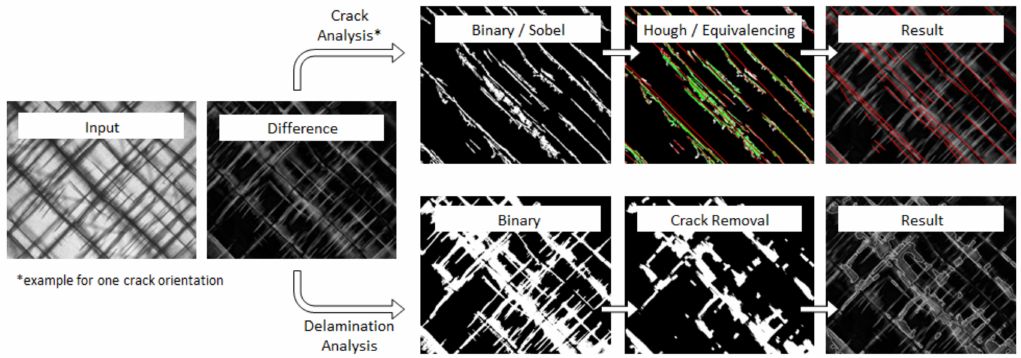
Figure 4. Illustration of the digital image analysis procedure used for damage content